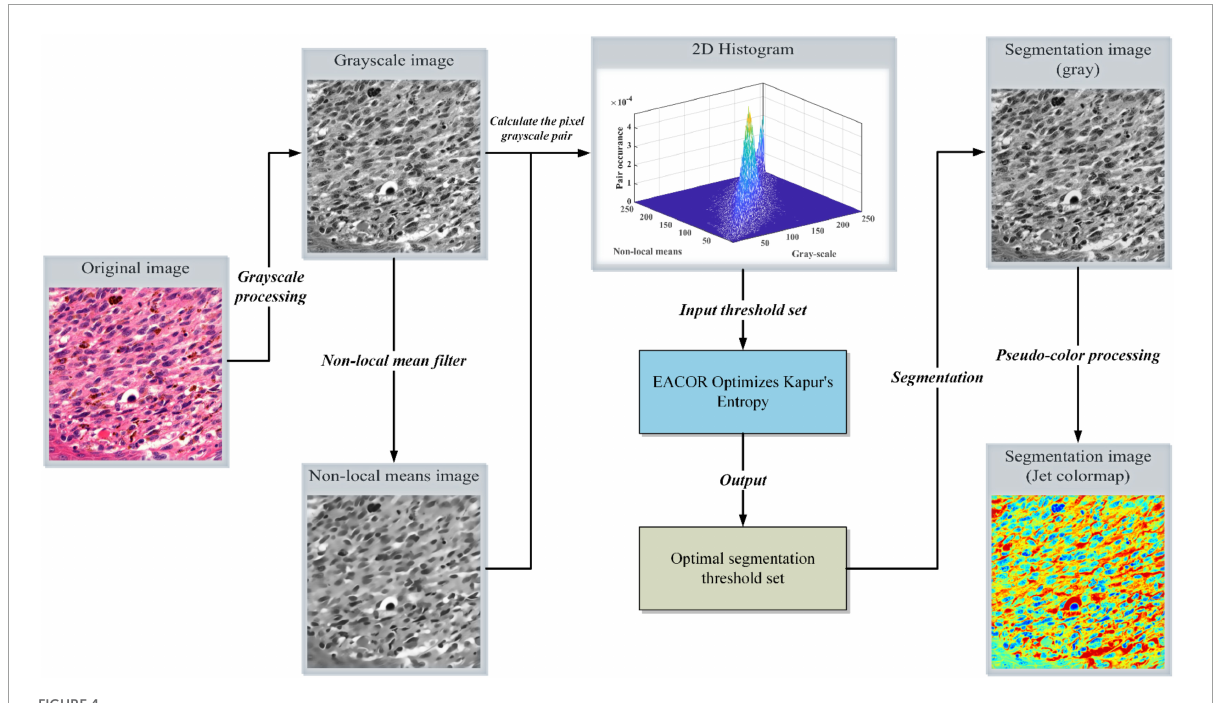
FIGURE4 Flowchart of image